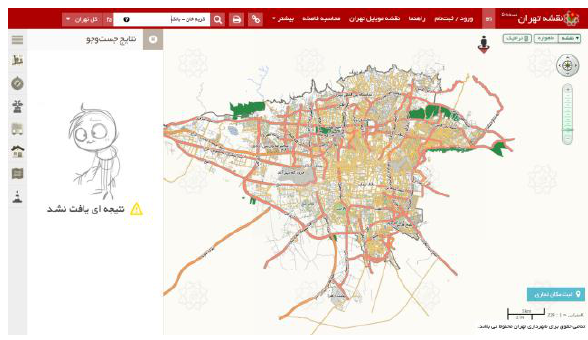
Figure 9. Output of Search Address in Open Route Service